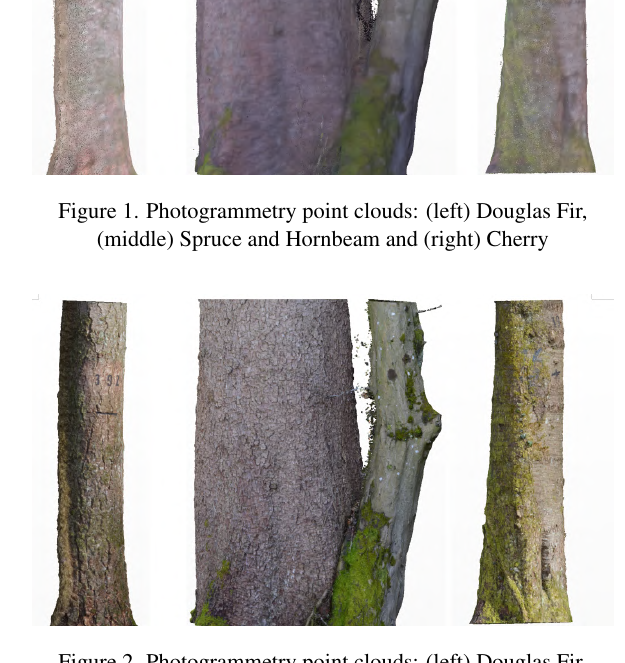
Figure 2. Photogrammetry point clouds: (left) Douglas Fir, (middle) Spruce and Hornbeam and (right) Cherry